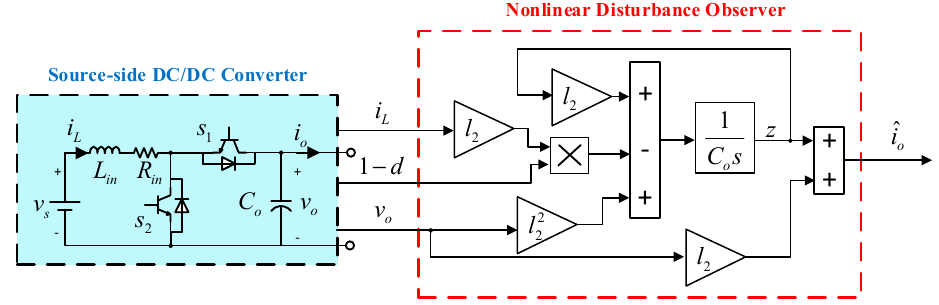
Figure 5. Structure of the proposed nonlinear disturbance observer for the source-side converter.